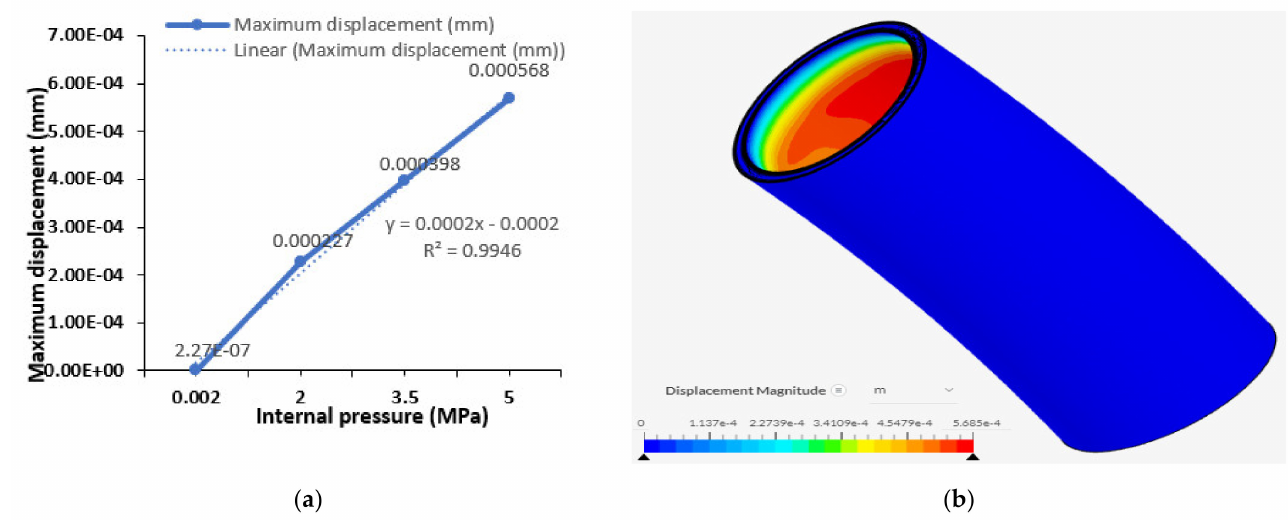
Figure 17. Deformation Profile of the bonded flexible hose under internal pressure, showing ( a ) the displacement profile under internal pressure at 5 MPa, and ( b ) Maximum displacement of the hose.